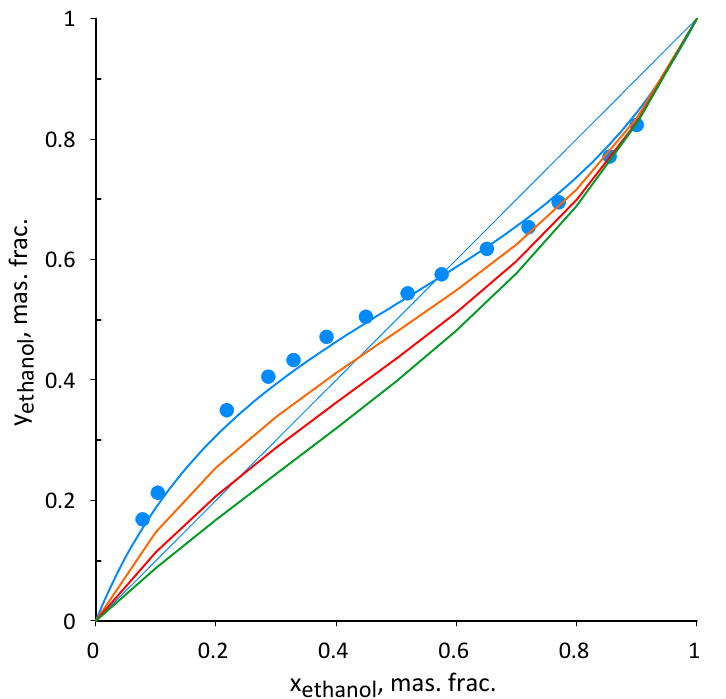
Figure 10. Equilibrium compositions of vapor and liquid in the ethanol- acetonitrile-AEBA–TEG system. The lines are the calculation according to the UNIFAC model (Table 2), the dots are the experimental data from [61]. AEBA–TEG concentration: points, blue line—0 wt.%, yellow line—20 wt.%, red line—40 wt.%, green line—60 wt.%.